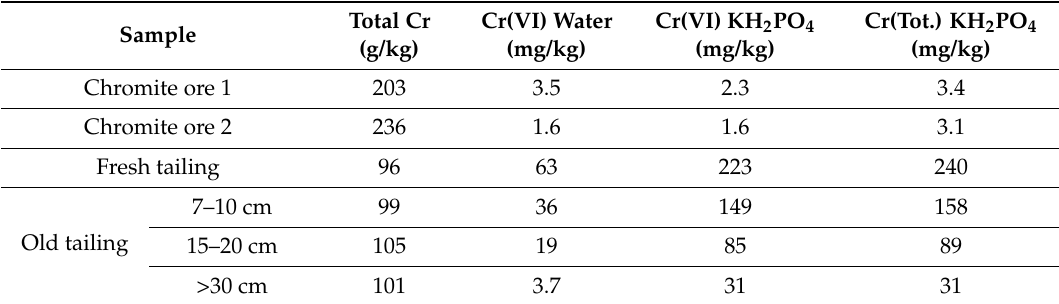
Table 2. Results of chemical extraction for the tailings and chromite ore